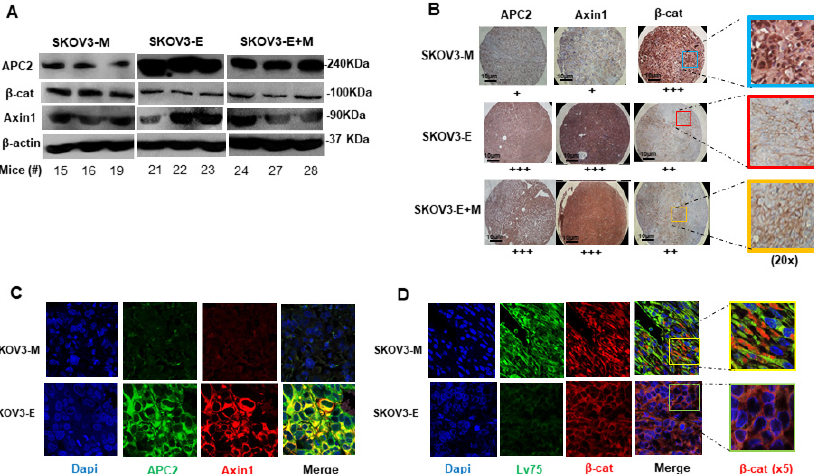
Figure 2. Analysis of the Wnt/B-catenin pathway status in primary tumor tissue samples of phase 1 mice experimental groups IB-injected with SKOV3-M, SKOV3-E or SKOV3-E + M cells. ( A ) Western blot analysis of β -catenin, APC2 and Axin1 proteins in SKOV3-M (mice 15, 16 and 19), SKOV3-E (mice 21, 22 and 23) and SKOV3-E + M mice (samples 24, 27 and 28). β -actin was used as the loading control. ( B ) Immunohistochemistry (IHC) analysis of the expression of β -catenin, APC2 and Axin1 and β -catenin sub-cellular localization in tumor tissues extracted from mice injected with the SKOV3-M, SKOV3-E and SKOV3-E+M cells at 40× (scale bar 10 μ m). The plus symbols (+ to +++) indicate the level of expression (from lower to higher) of the corresponding protein. ( C ) Immunofluorescence (IF) analysis of β -catenin, APC2 and Axin1 expression in tumor tissues extracted from mice injected with SKOV3-M and SKOV3-E cells (magnification at 60×). ( D ) IF analysis of Ly75, β -catenin and β -catenin sub-cellular localization in tumor tissues extracted from mice IB-injected with SKOV3-M and SKOV3-E cells (magnification at 40×).